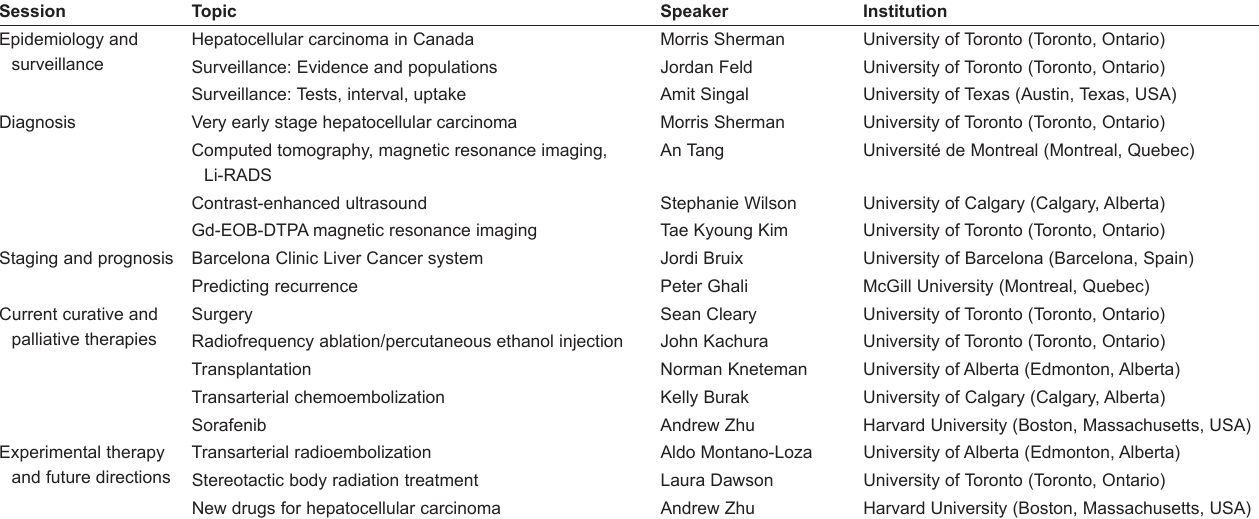
TABLE 1 Sessions, topics and speakers for the Canadian Association for the Study of the Liver hepatocellular carcinoma meeting Session